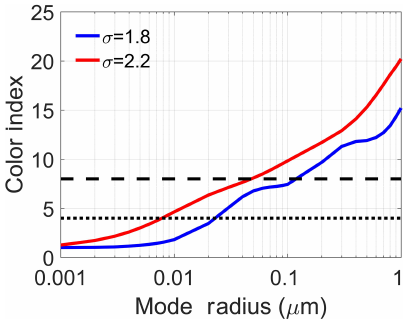
Figure 2. CI as a function of mode radius from Mie calculation assuming an index of refraction of 1.45 and a lognormal size dis- tribution with the indicated standard deviations ( σ ) of 1.8 and 2.2. The dotted and dashed lines represent the minimum ( ∼ 4) and max- imum ( ∼ 8) CI of the enhanced aerosol layer from COBALD mea- surement for all cases.